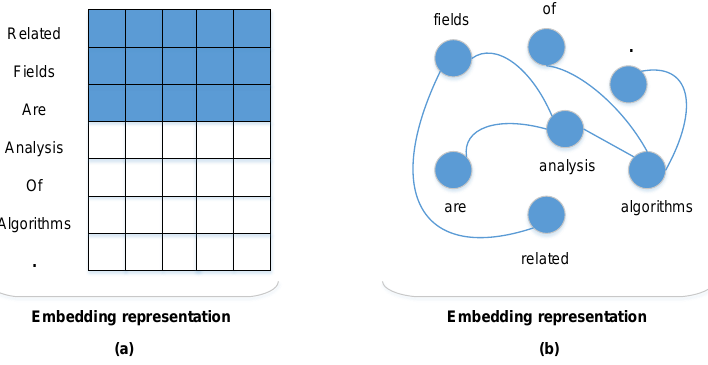
Figure 4. Difference between traditional convolution and graph convolution. ( a ) is the traditional convolution. ( b ) is the graph